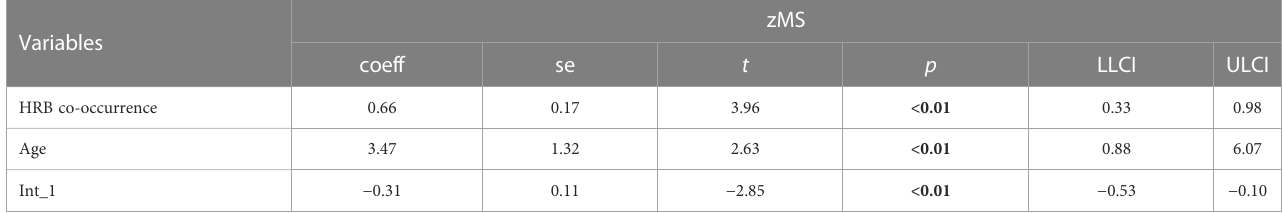
TABLE 6 The moderation analysis between zMS, HRB co-occurrence, and age.